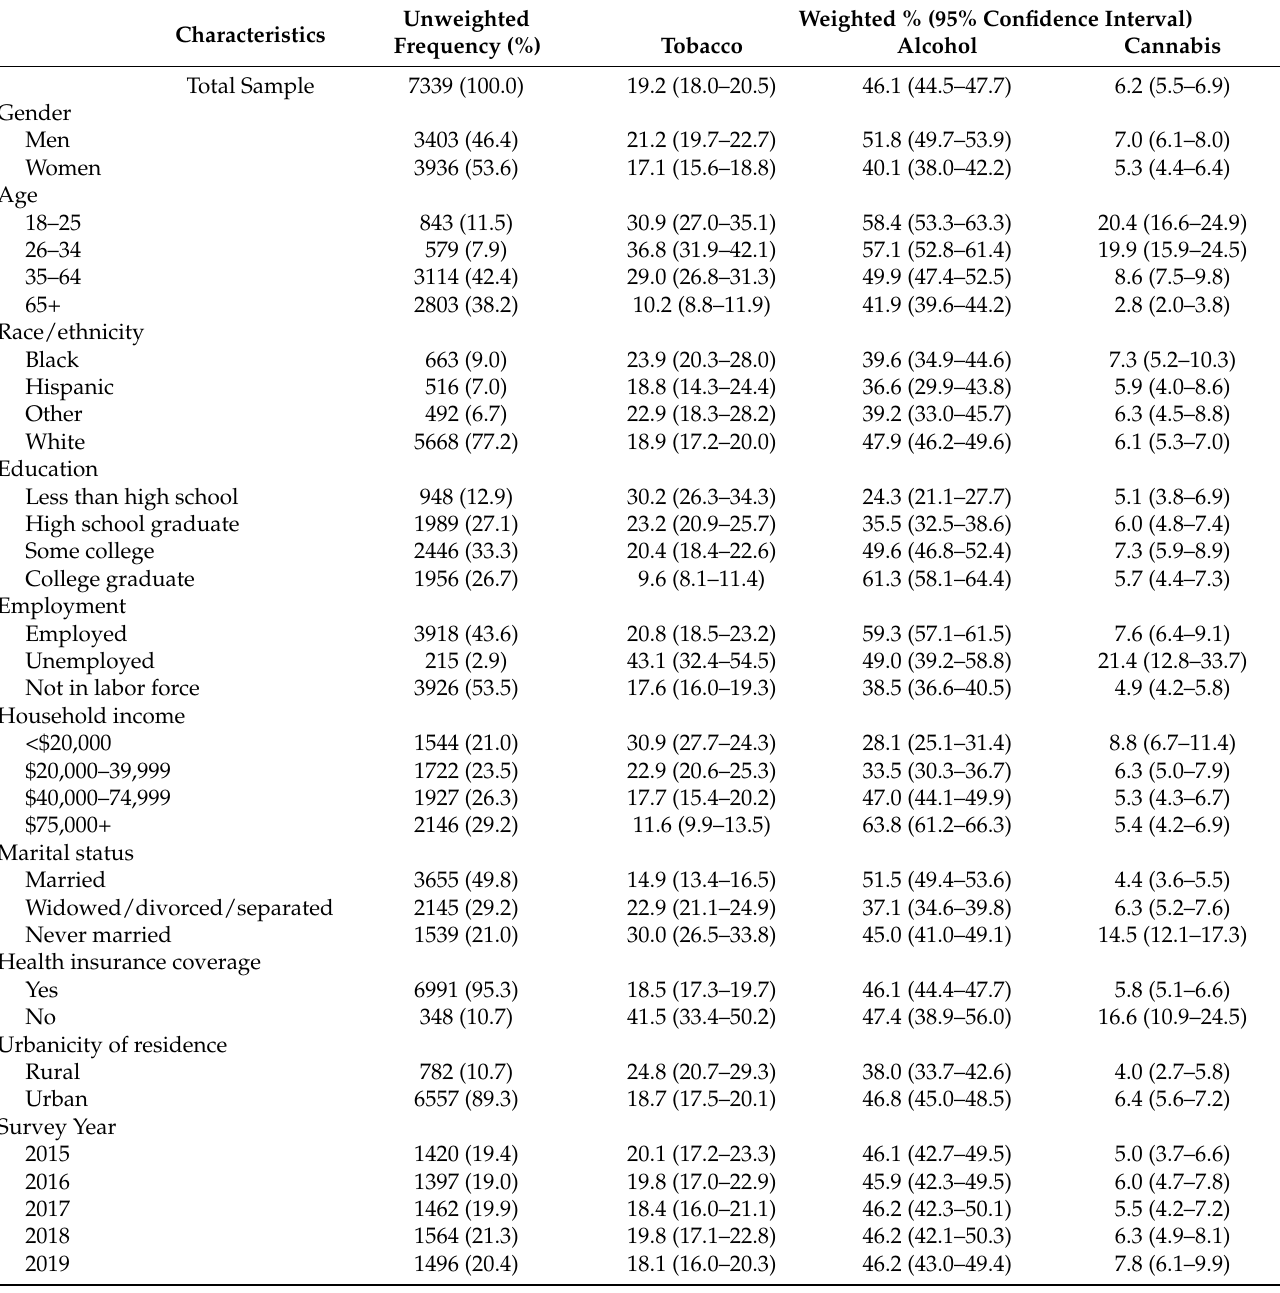
Table 1. Sample characteristics and prevalence of current substance use among adults with heart disease: pooled sample of NSDUH